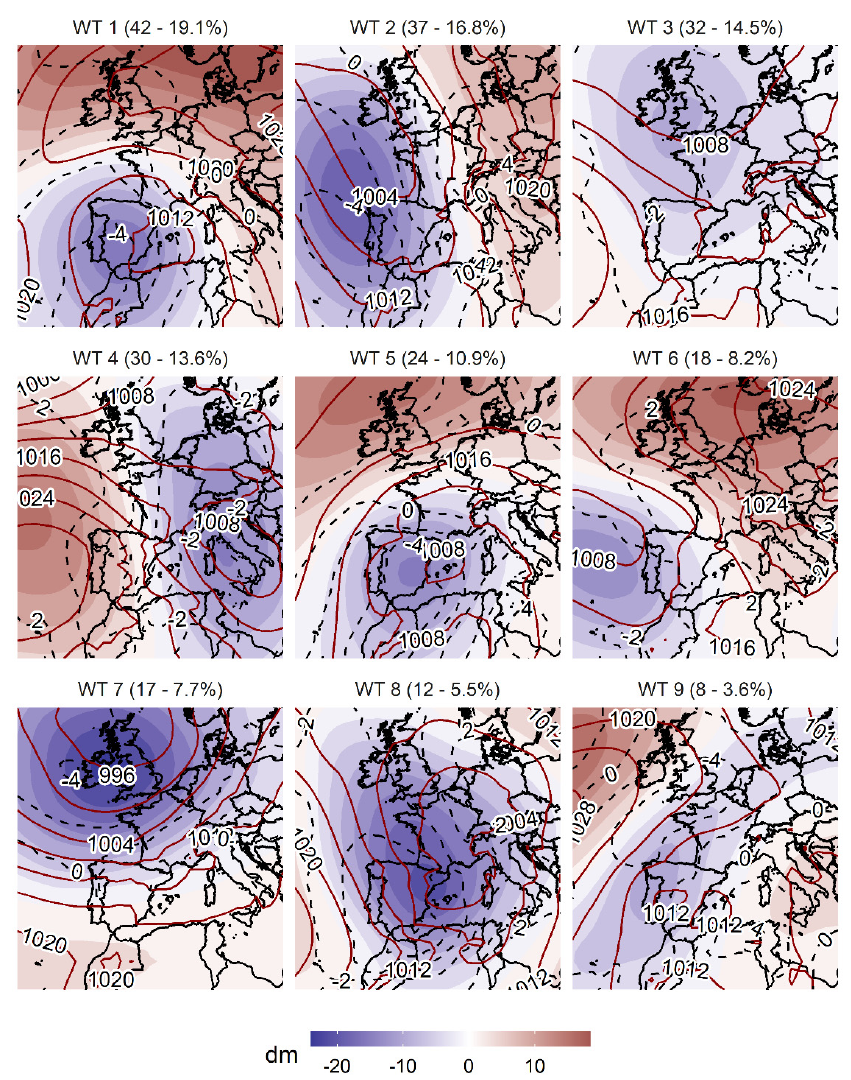
Figure 4. Mean sea level pressure (dark red contours, hPa), 500 hPa geopotential height anomalies (shaded colours, dam) and 850 hPa temperature anomalies (dashed contours) of the nine most frequent weather types associated with torrential precipitation in the western Mediterranean region. Above each map, the number of days assigned to each synoptic pattern and their percentages with respect to the total are shown in parentheses.